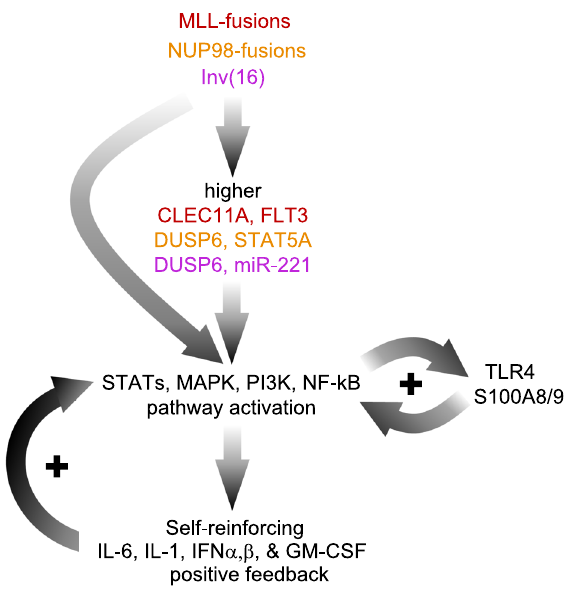
Fig.7|Schematicsummaryandmodeloftheregulatoryinteractionsreported. All 3 main genomic subtypes of high-IL6/R pAML upregulate genes that have been reported to activate multiple signal transduction pathways that in turn can upre- gulate IL-6, IL-1, IFN α / β , GM-CSF, and S100A8/9 mediated TLR signaling. Notably, all these signaling pathways can become self-reinforcing via positive feedback loops (marked by the ‘ + ’